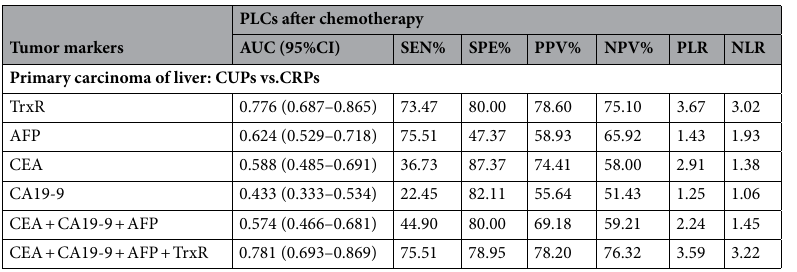
Table 2. The assessment of therapeutic efficiency by TrxR, AFP, CA19-9, and CEA and their combinations after chemotherapy in PLC patients. SPE: specificity; SEN: sensitivity; NPV: negative predictive value; PPV: positive predictive value;NLR: negative likelihood ratio. PLR: positive likelihood ratio; the diagnosic threshold of TrxR activity level was 7.45 U/mL in PLC patients.